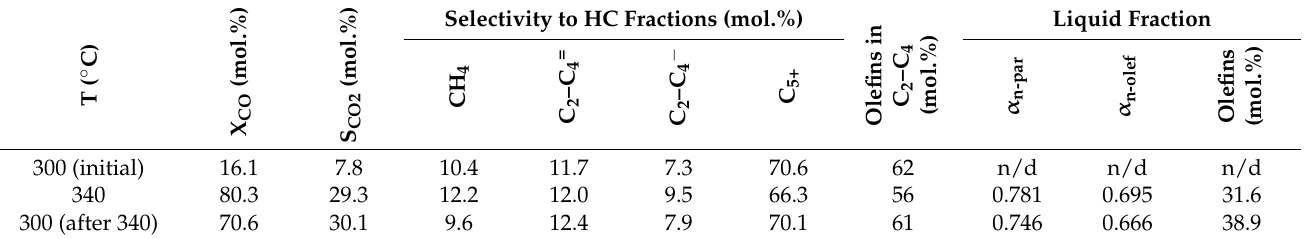
Table 2. Performance of FeKNGNF700 catalyst in FTS (20 bar, 5 NL/g cat /h, CO:H 2 = 1:1) at differ- ent